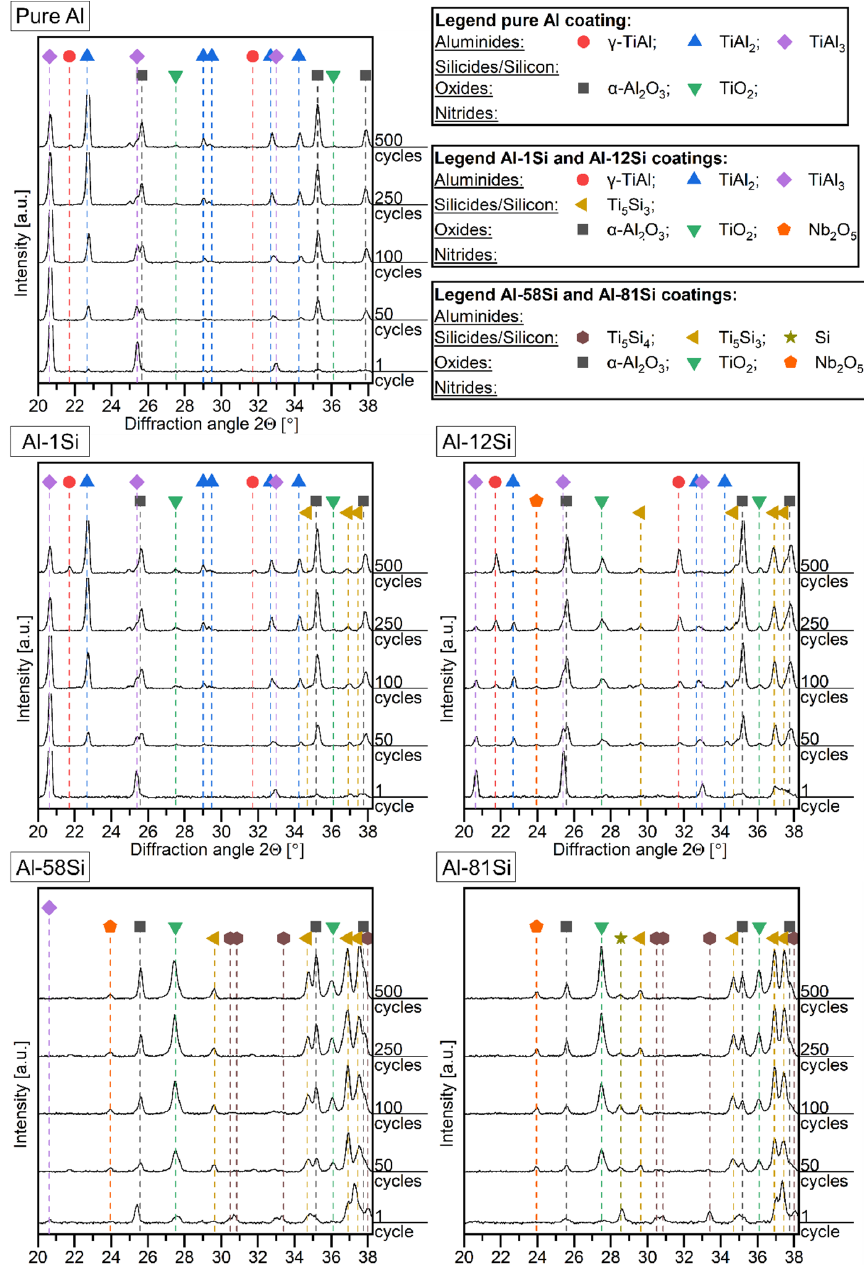
Figure 5. X-ray diffractograms of the pure Al, Al-Si coatings (Al-1Si, Al-12Si, Al-58Si and Al-81Si, all in at.%) and the uncoated TNB-V2 substrate after different amounts of 1 h cycles at 900 °C in air. The Al-12Si coating consisted of the TiAl 3 phase as well as Ti 5 Si 3 , which started to form after the first cycle of oxidation but was not yet present after the vacuum heat treat- ment at 600 °C.